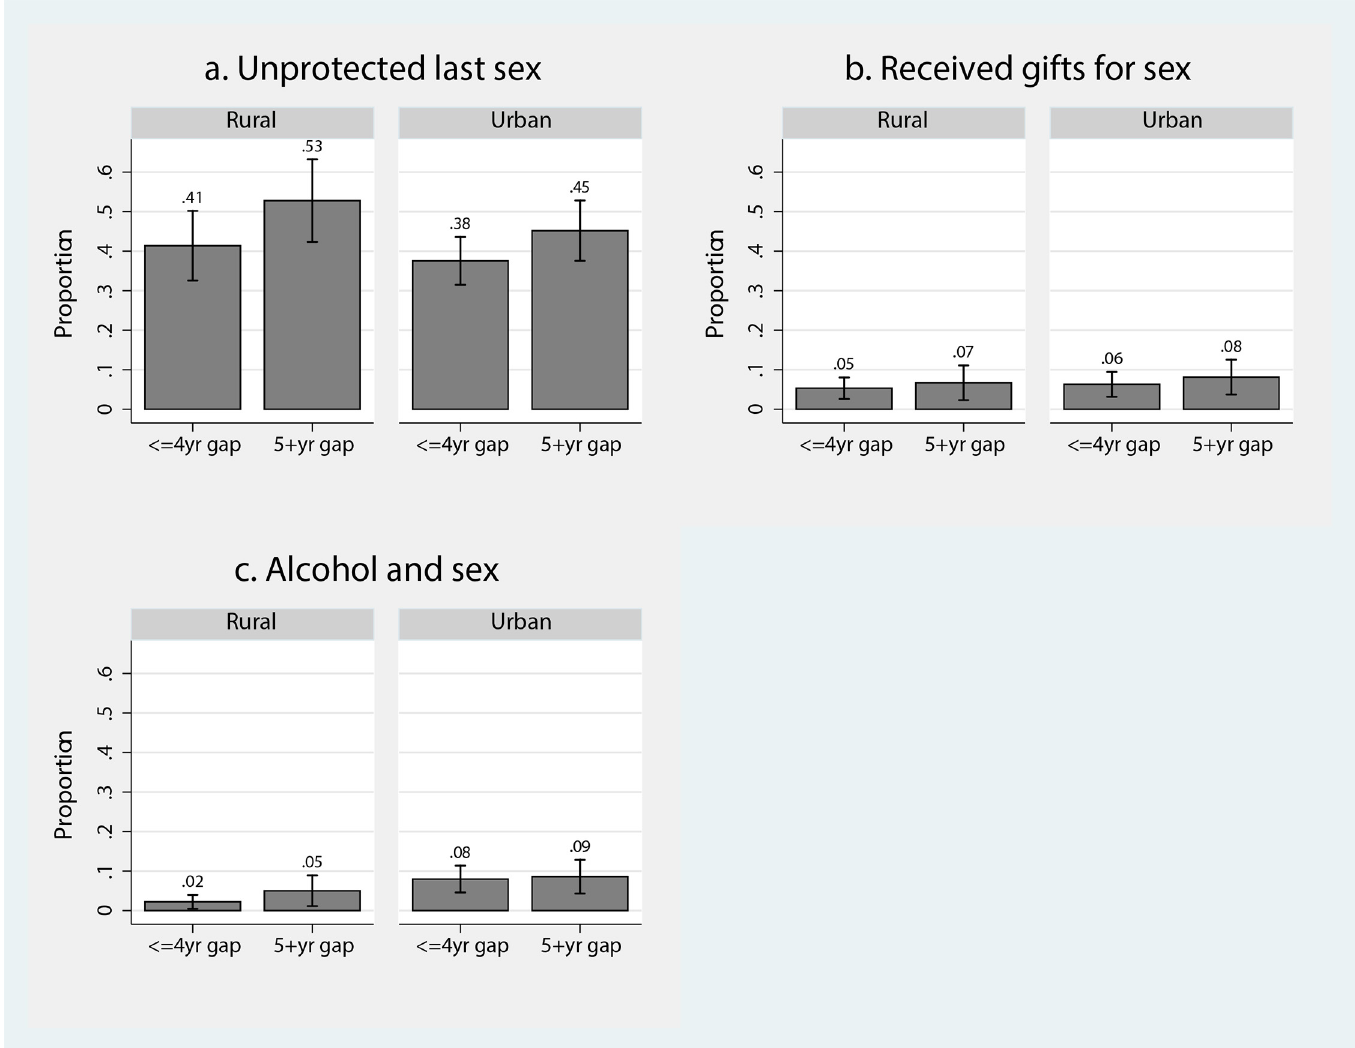
Fig 1. Sexual behaviours reported by 16 – 24 year old women by partnership type (age-disparate v age-similar) and geographic (urban/rural) setting. 1a: unprotected last sex; 1b: received gifts for sex; 1c: alcohol and sex.